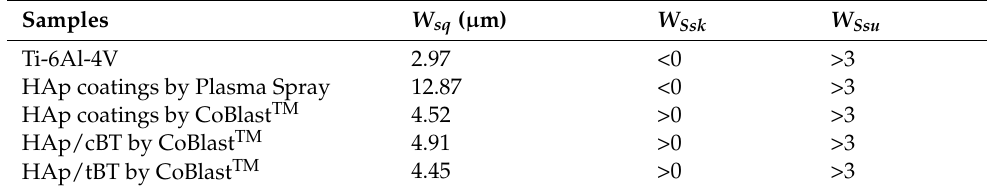
Table 5. Mean roughness measurements ( W Sq ) of coated and uncoated samples.